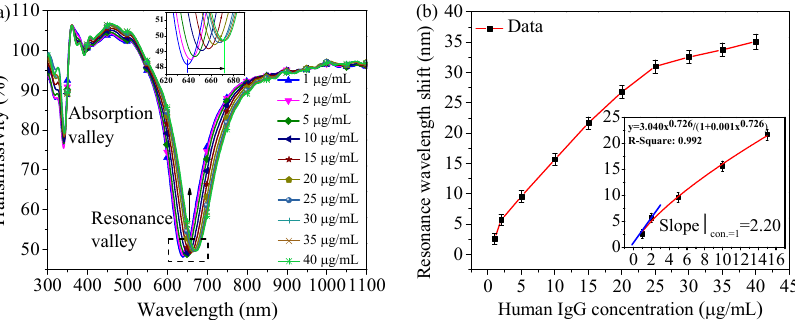
Figure 7. ( a ) Transmission spectrum obtained by the sensor detecting H-IgG solutions with different concentrations. (The position of each resonance curve is the stable position when detecting the corresponding H-IgG solution.) ( b ) Resonance curve shift corresponding to the detection of H-IgG solutions in various concentrations. Error bar = ± S.D., and the same assay in the same experimental conditions is repeated three times. Inset: calculation of sensor’s sensitivity.